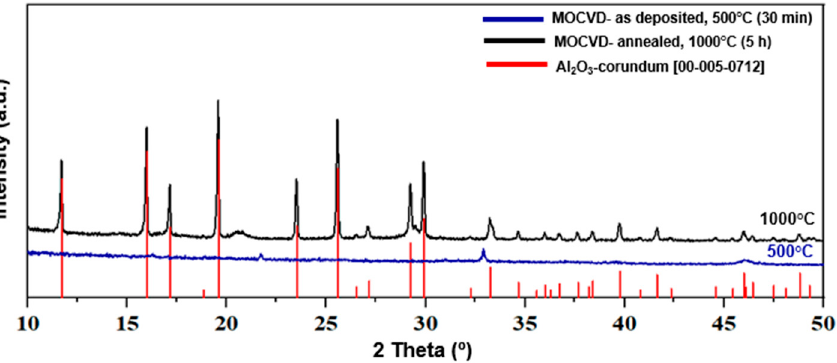
Figure 6. XRD pattern of 4a showing as-deposited and annealed Al strates.